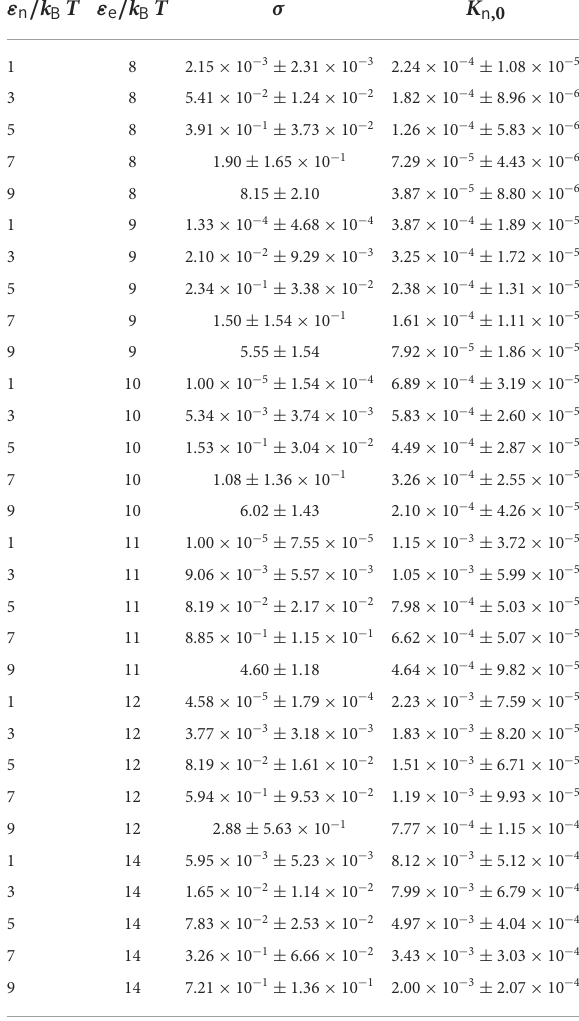
TABLE 2 Shown are the results from varying ε n for multiple different values of ε e , in the absence of hydrophobic interactions i.e., ε H = 0 k B T . ε n / k B T ε e / k B T σ K n ,0